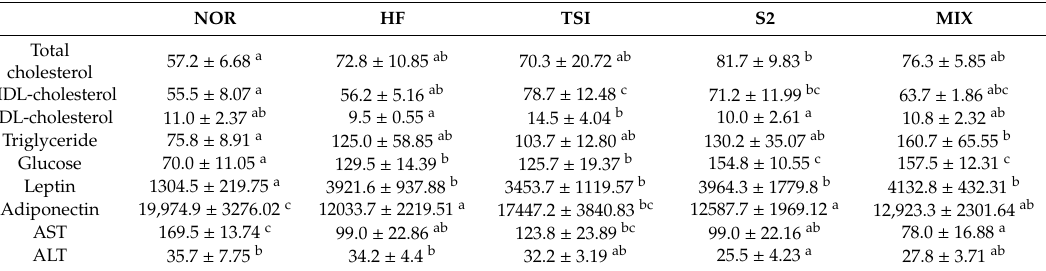
Table 8. Blood serum levels of cholesterol, triglyceride, glucose, leptin, aspartate transaminase, and alanine transaminase in SD rats fed with experimental diet for 8 weeks.